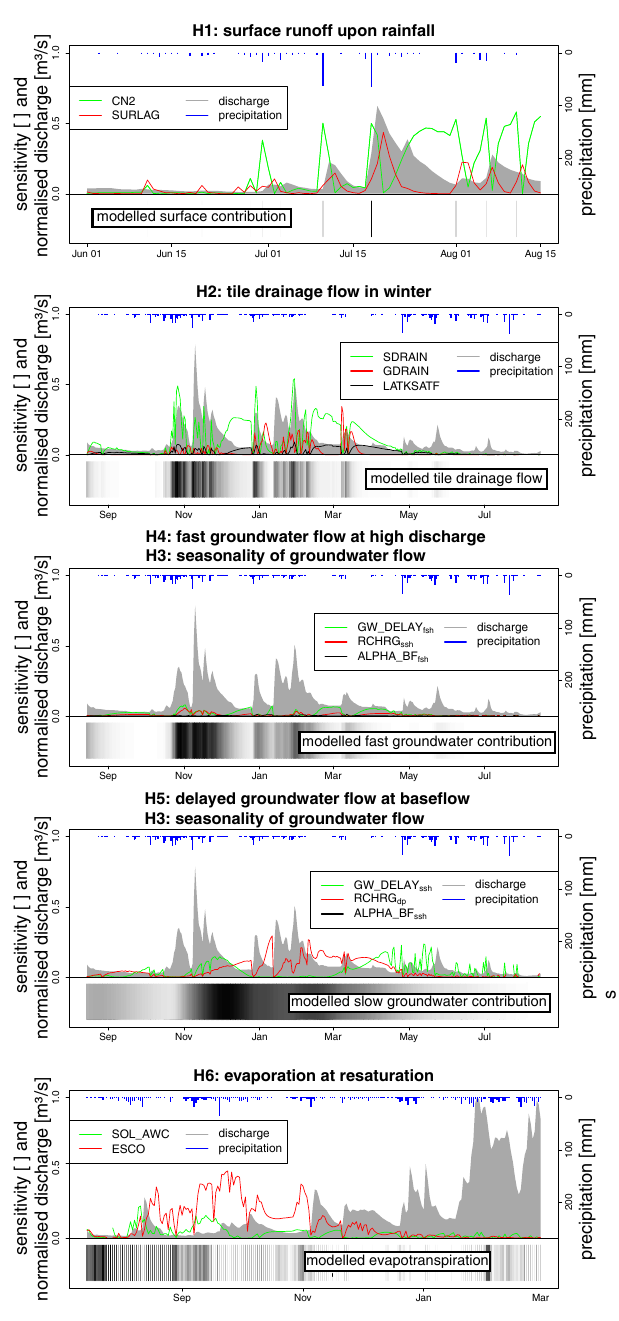
Figure 4. Periods of temporal parameter sensitivities for the veri- fication of hypotheses about surface runoff (H1), tile drainage flow (H2), the process dynamics of the fast shallow aquifer (H3, H4) and the slow shallow aquifer (H3, H5), evaporation, and soil water stor- age (H6). The normalised observed discharge and the precipitation are shown for each subplot. Additionally, the modelled hydrological output is averaged and normalised to show the range between low (white) and high (black)